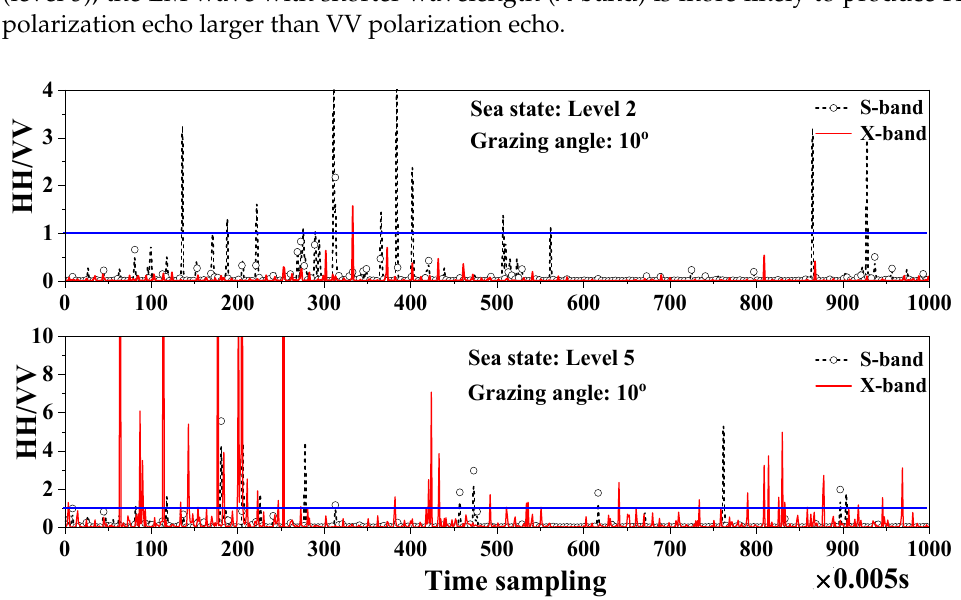
Figure 10. The mean value of different polarized sea clutter amplitudes in the X-band of the Yellow Sea varies with wave height.